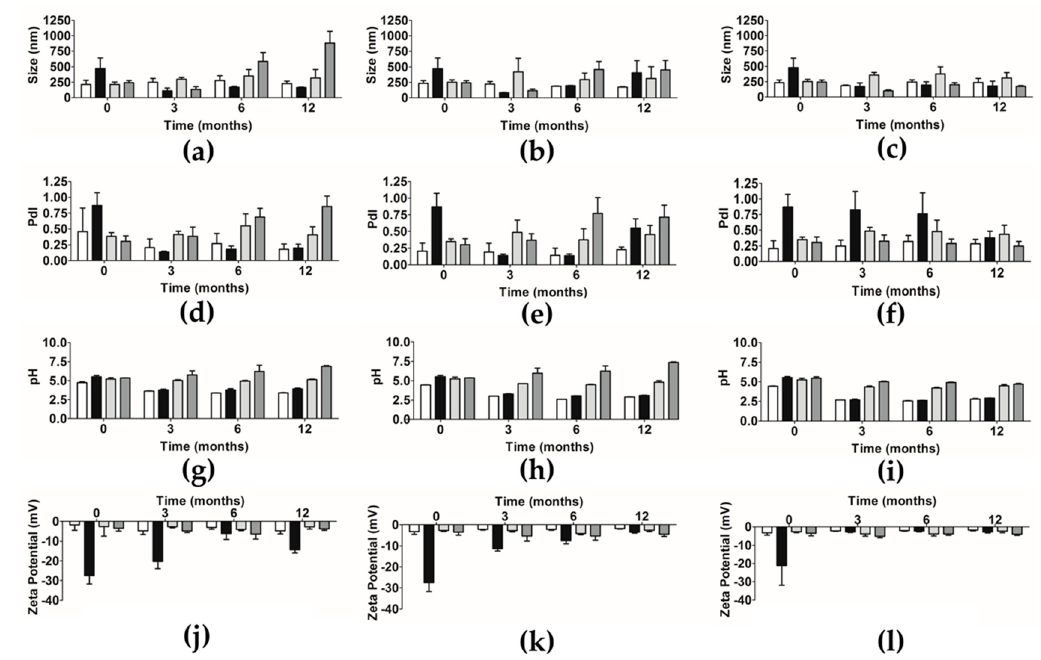
Figure 4. Mean size, PdI, pH, and zeta potential of empty PLGA NPs (white columns), empty PCL NPs (light grey columns), extract-loaded PLGA NPs (black columns) and extract-loaded PCL NPs (dark grey columns) suspension over time: mean size ( a – c ), PdI ( d – f ), pH ( g – i ), and zeta potential ( j – l ). ( a ) size at RC, ( b ) size at RT, ( c ) size at AC, ( d ) PdI at RC, ( e ) PdI at RT, ( f ) PdI at AC, ( g ) pH at RC, ( h ) pH at RT, ( i ) pH at AC, ( j ) zeta potential at RC, ( k ) zeta potential at RT, and ( l ) zeta potential at AC (mean ± S.D., n = 9). Refrigerated Conditions—RC, Room Temperature—RT, and Accelerated